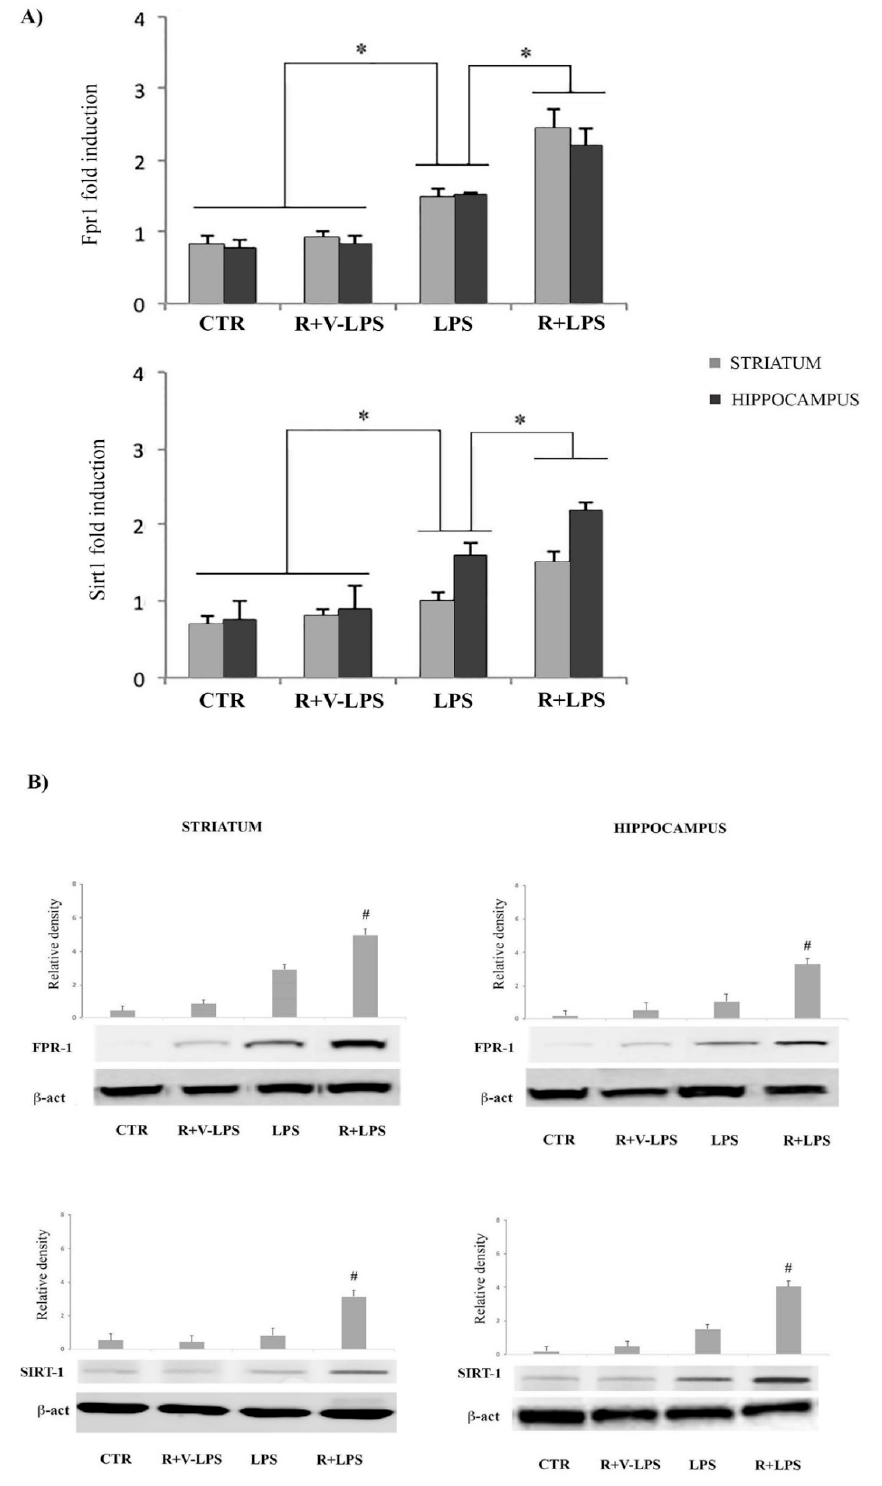
Figure 6. ( A ) Real-time PCR analysis of Fpr1 (upper) and Sirt1 (lower) mRNA expression in the striatum and hippocampus of untreated controls mice (CTR), mice treated with resveratrol and LPS vehicle (R+V-LPS), LPS-treated mice (LPS) and resveratrol plus LPS treated mice (R+LPS). ( B ) Western blotting detection and densitometric analysis of FPR1 (upper) and SIRT1 (lower). Real-time PCR analysis results represent the mRNA fold changes relative to GAPDH used as resident control. Protein expression analysis values are expressed as arbitrary units after normalization against β -actin, used as a loading control. All values are expressed as means ± SD ( n = 5 per group, 5 replicates). * p < 0.05 significantly different; # p < 0.05 vs.